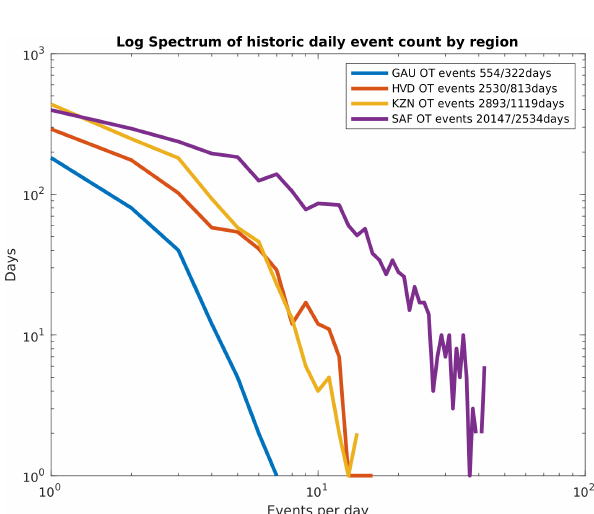
Figure 15. Spectrum of number of events per day on historic event days for the entire country (SAF), the Highveld (HVD), KwaZulu- Natal (KZN), and Gauteng (GAU).